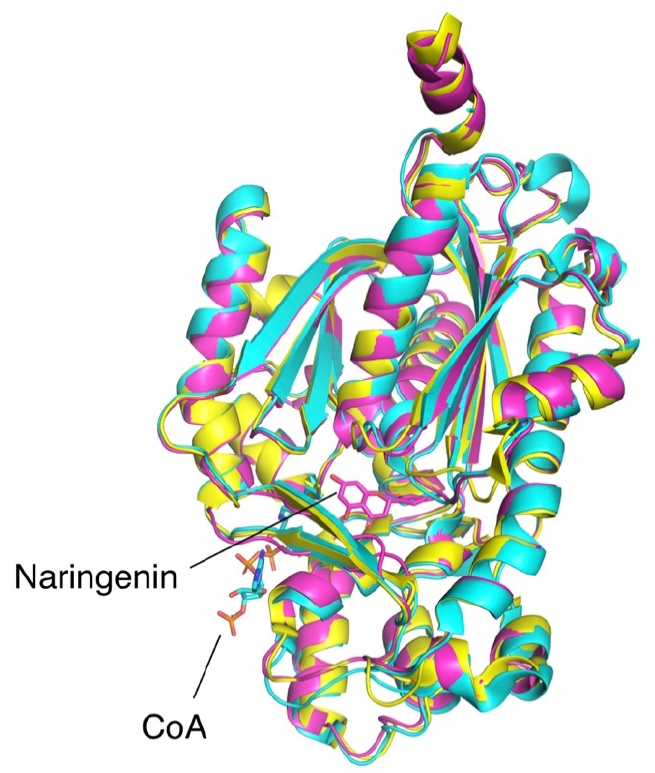
Figure 2. Superimposed structures of OLS (cyan, PDB 6GW3 [23]), stilbene synthase (yellow, PDB 1U0U [28]), and chalcone synthase (purple, PDB 1CGK [29]). Shown ligands CoA and naringenin are co-crystallized with OLS and chalcone synthase,